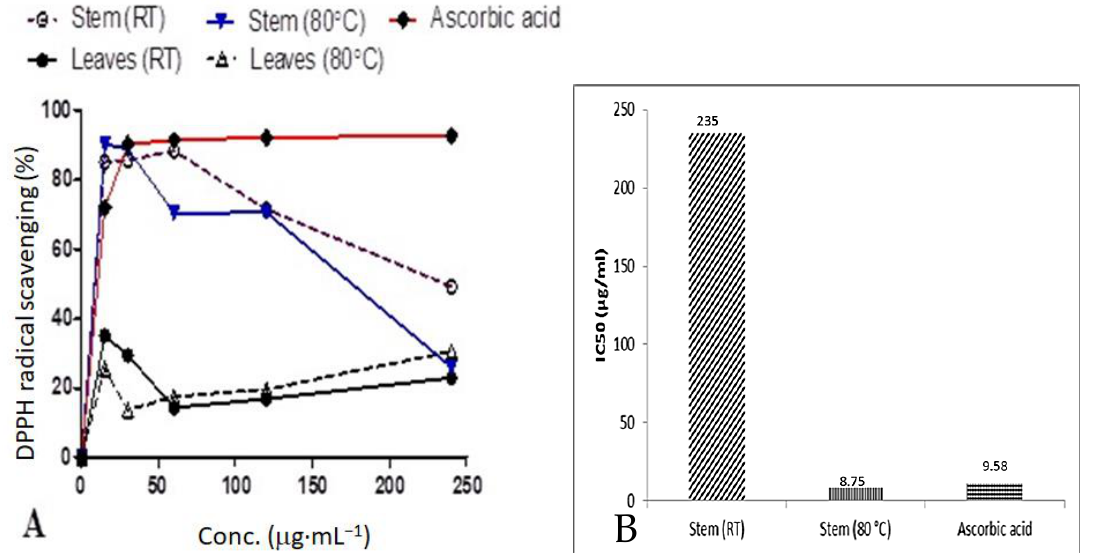
Figure 7. Comparison of percentage DPPH radical scavenging activities ( A ) and the IC 50 values ( B ) of D. villosa leaves and stem bark AgNPs at room temperature (RT) and 80 °C.